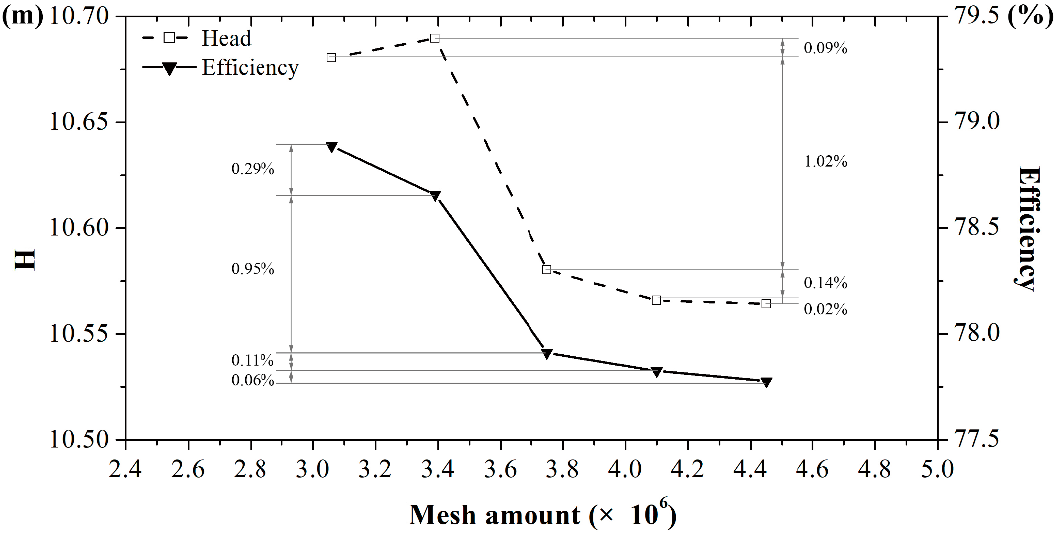
Figure 2. Influence of mesh amount on the head and efficiency.